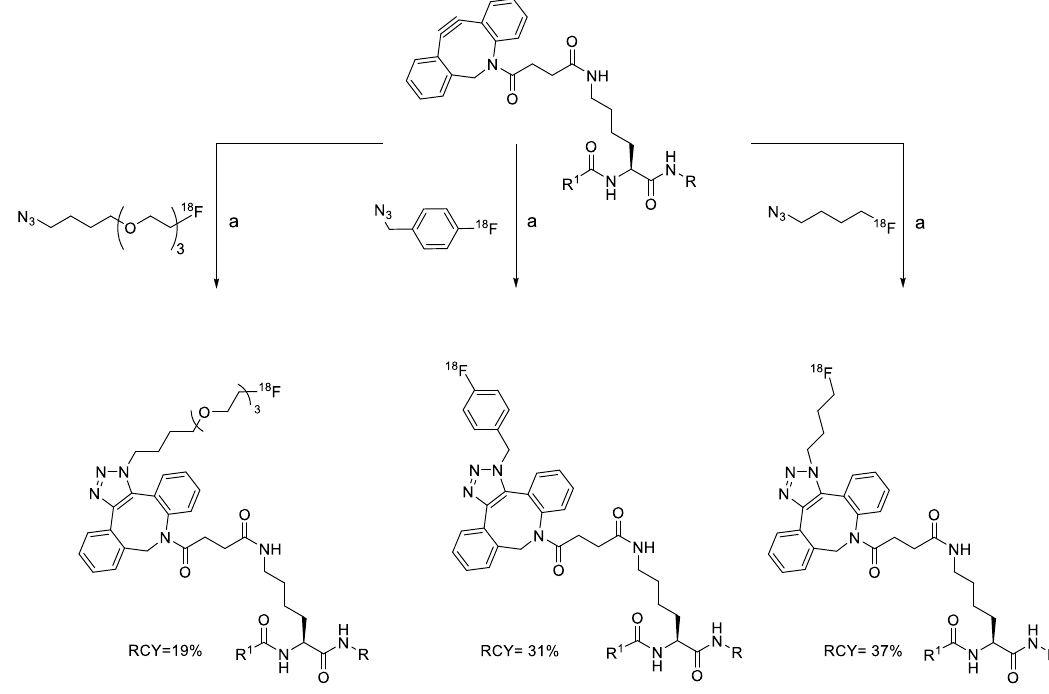
Figure 2. 18 F-radiolabeling of bombesin derivative using SPAAC: a ) human plasma or dimethyl sulfoxide (DMSO), room temperature, 15 min. R = Pyr-Gln, Pyr = pyroglutamic acid, R 1